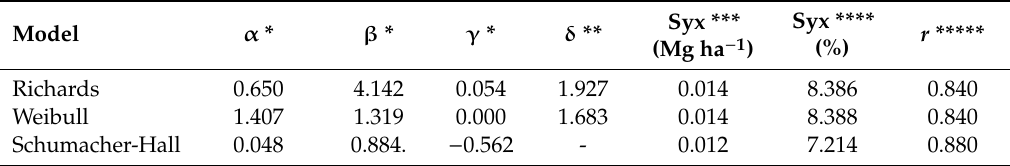
Table 7. Statistical parameters of the non-linear models obtained in the adjustment of the amount of phosphorus in the eucalypt